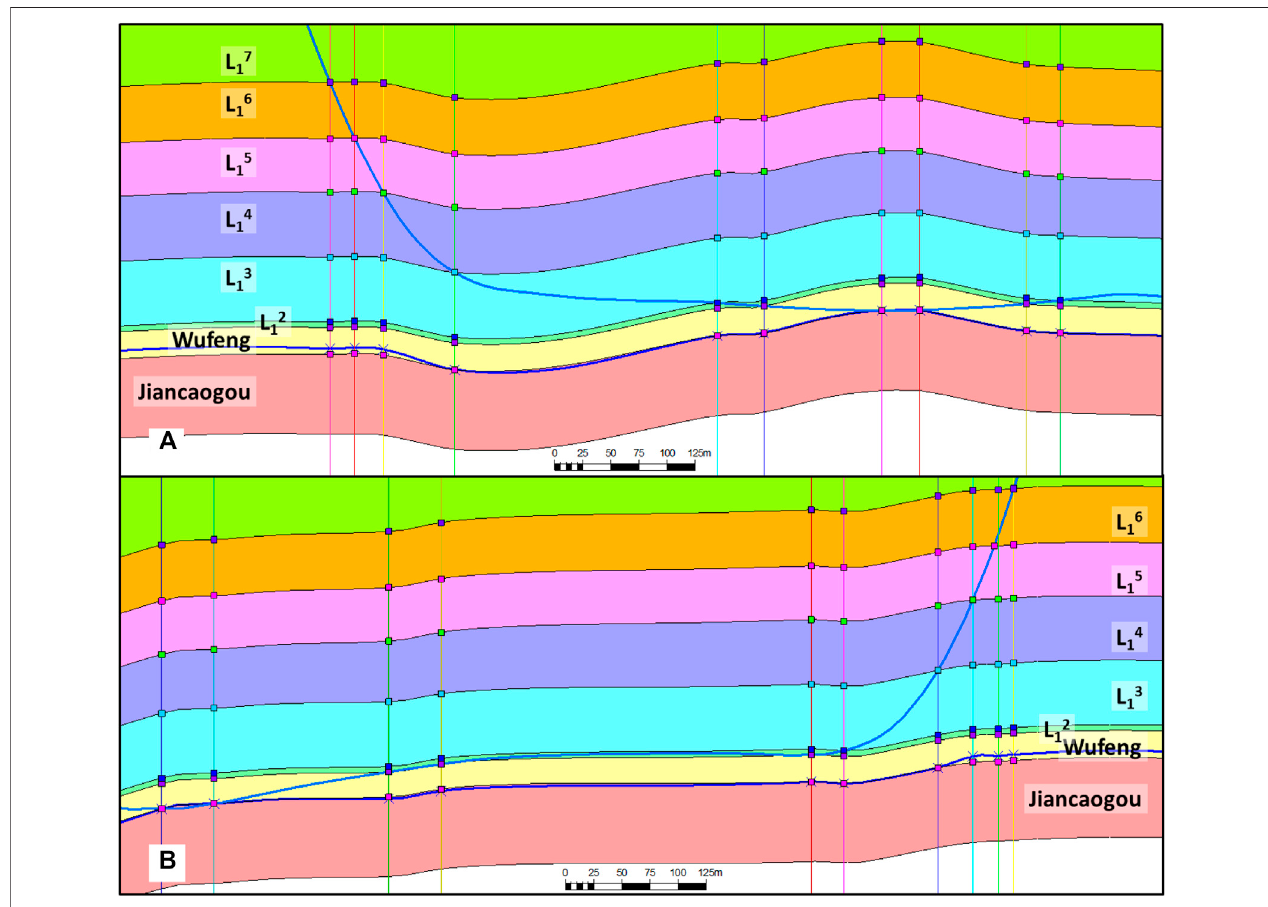
FIGURE 7 | Cross sections of wells JY-b and JY-c with the inferred formation tops in PVW-As. The blue X and the blue curve represent the formation top for the WufengbasethatwascalculatedusingtheTVTsfromthewellJY-1andtheWufengbasestructuralmapmadefromtheseinferredformationtop.Thecolor- fi lledsquares in the PVW-As are the formation tops after adjusting the TVTs for shale layers based on the dip angle change threshold of 2.5 o .